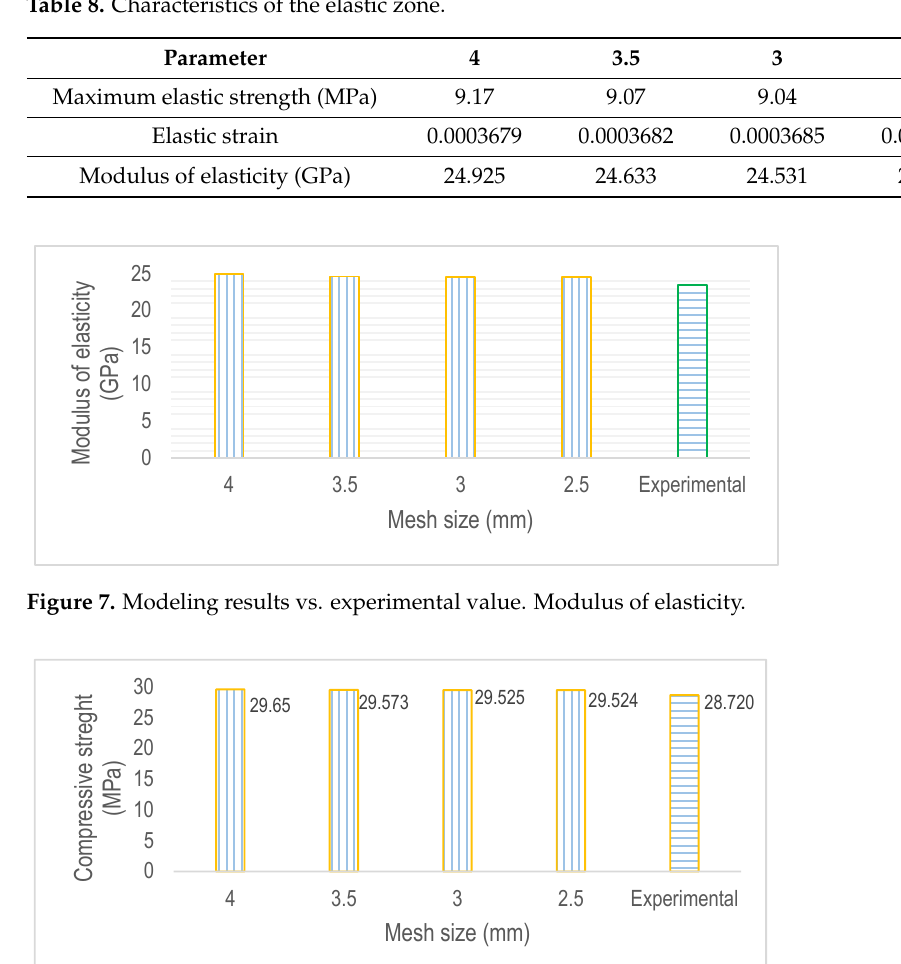
Figure 6. Granulometric curves used.